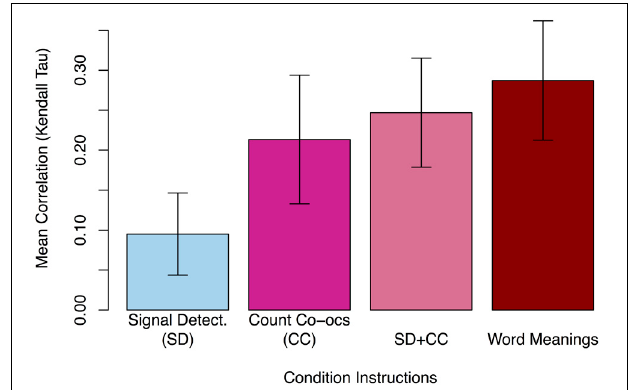
FIGURE 4 | Mean rank correlation ( τ ) of each participant’s responses with the actual number of pairing co-occurrences in Experiment 2. Asking participants to learn word meanings produced the highest correlation, followed closely by the joint signal detection and count co-occurrences dual-task condition (SD + CC) and the count co-occurrences task. The signal detection task alone produced a significant but small positive correlation. Error bars show 95% CI.